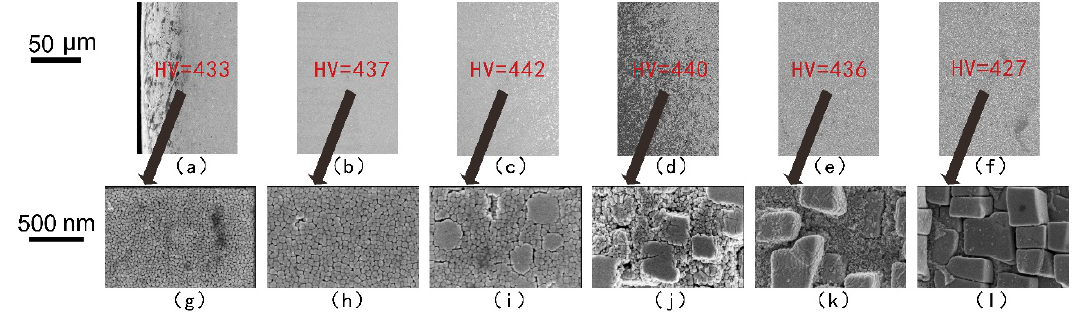
Figure 3. SEM micrographs showing the transverse section of the plasma arc re-melted DD407 alloy in the ( a , b ) fusion zone, ( c – e ) heat-affected zone, and ( f ) substrate zone. ( g – l ) SEM images of high magnification in the center of the images above. The micro-HV data are highlighted in red.